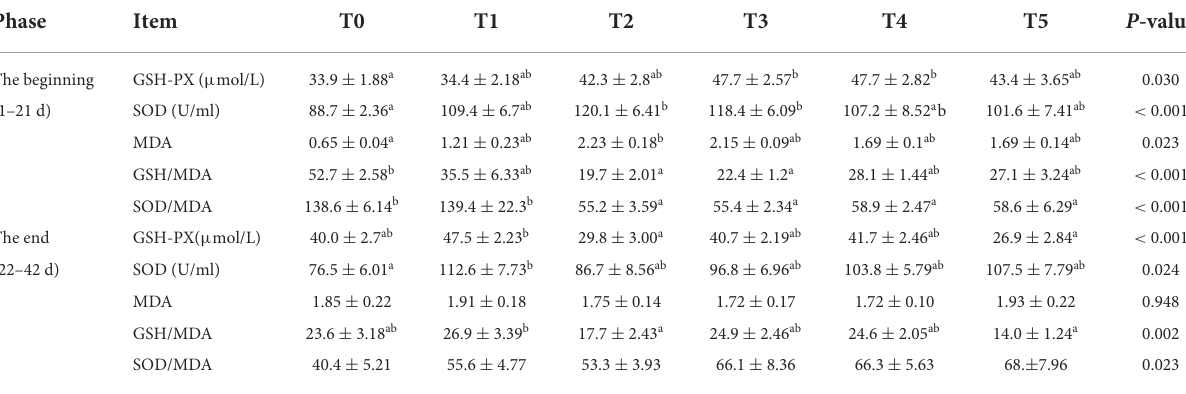
TABLE 5 Effects of adding CAP difference level on antioxidant parameters of white-feather broilers (means ±